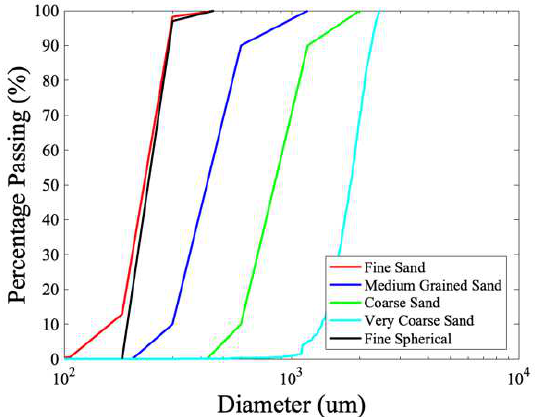
Figure 1. The particle size distributions (PSDs) of the base materials used in this study.